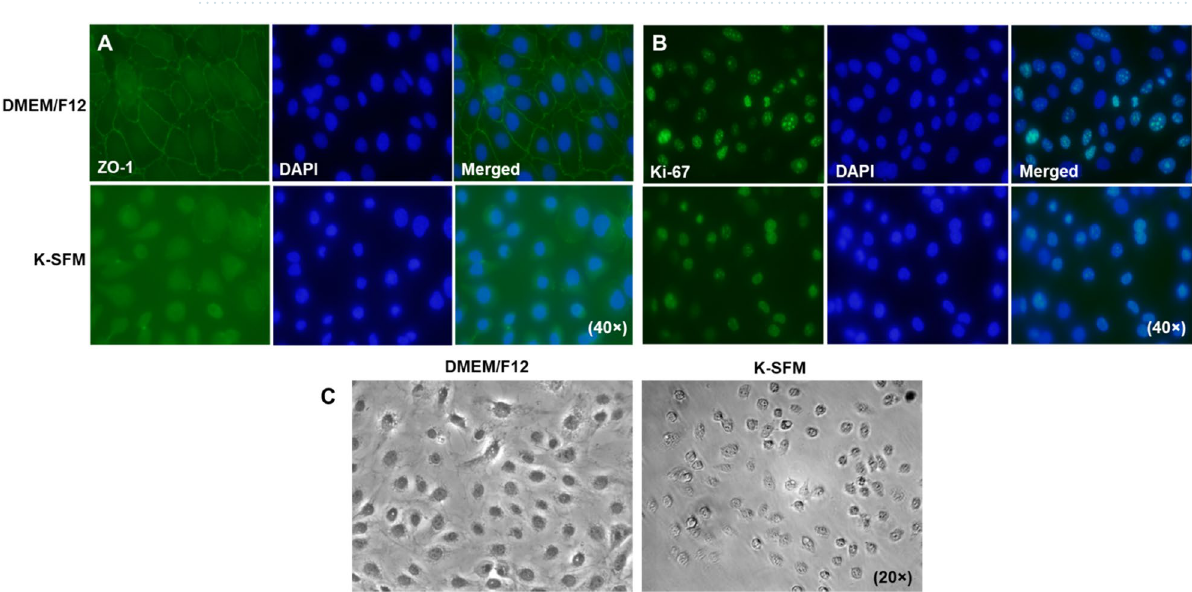
Figure 6. Mathematical modeling of α, R b , and C m for HUCLs grown in DMEM/F12 versus K-SFM media. Modeled parameters, α ( A ), R b ( B ), and C m ( C ) were traced over 15 h for cells seeded at 60,000. Time = 0 denotes time of inoculation. Bar graphs represent total and end-point values from DMEM/F12 versus K-SFM media for α ( D ) and R b ( E ); end-point only is shown for C m ( F ). Data shown are the mean ± SEM; n = 5/group. * p ≤ 0.05, ** p ≤ 0.01 and *** p ≤ 0.001.